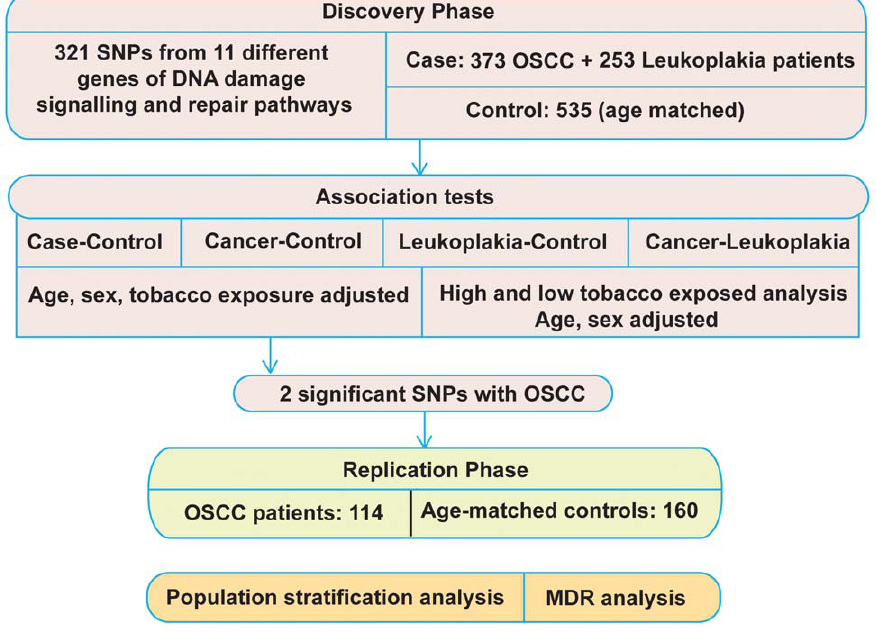
Figure 1. Overall strategy of the association study.